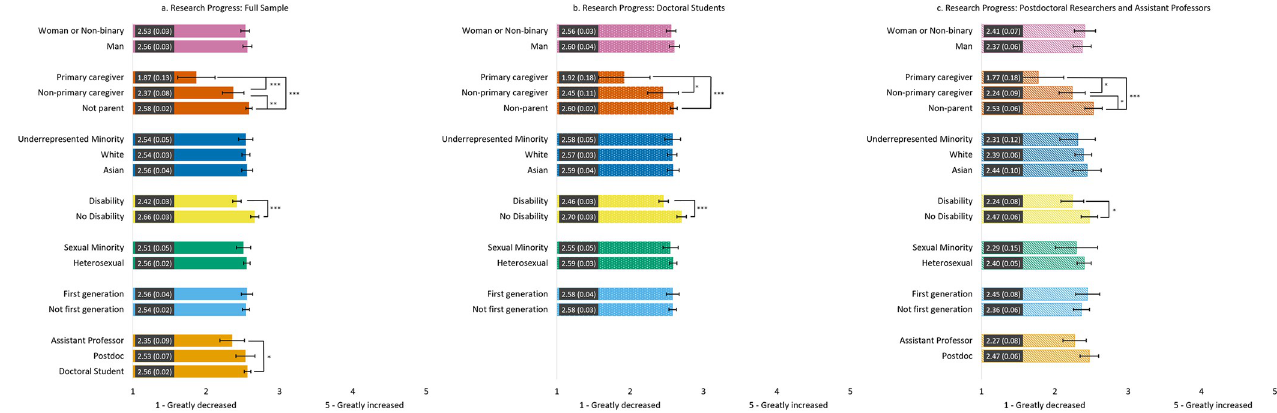
Fig 1. Estimated marginal means of reported change in research progress due to the COVID-19 pandemic for the full sample (1a) and the doctoral student (1b) and postdoc/asst prof (1c) subsamples. Participants were asked to rate the degree to which research progress changed on a Likert scale from 1 = Greatly decreased to 5 = Greatly increased . Error bars represent the 95% CI. Numeric values in each bar are the estimated marginal mean and standard error. � indicates p < .05, �� indicates p < .01, and ��� indicates p < .001. See S3 Table in S1 File for results of each model.